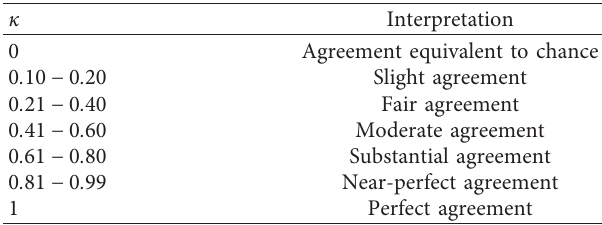
Table 3: Interpretation of Cohen’s Kappa